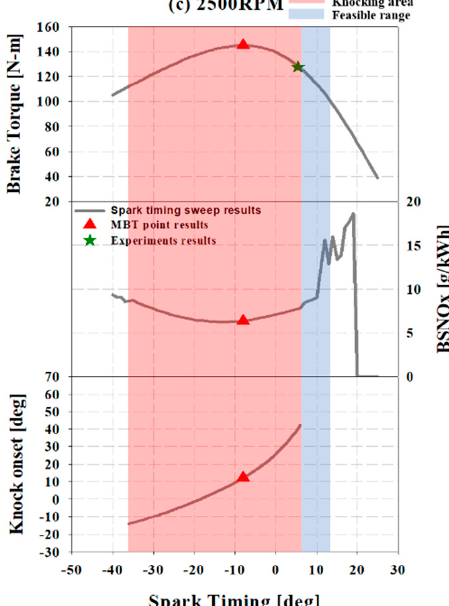
Figure 6. ( a ) Knocking occurrence, torque change, and NOx emission amounts according to changes in spark timing at 1600 RPM. ( b ) Knocking occurrence, torque change, and NOx emission amounts according to changes in spark timing at 1800 RPM. ( c ) Knocking occurrence, torque change, and NOx emission amounts according to changes in spark timing at 2500 RPM.